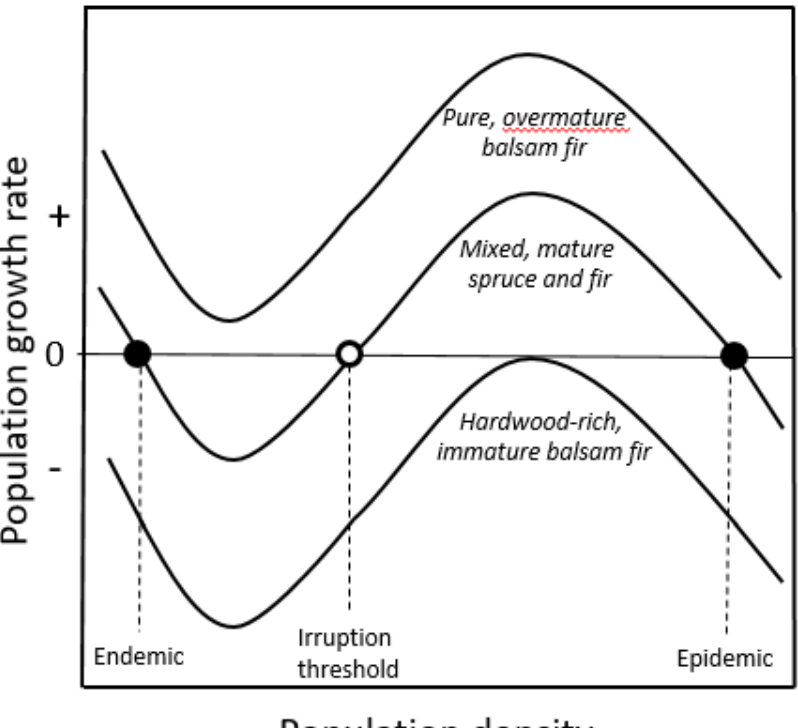
Figure 3. Hypothetical recruitment curves for spruce budworm showing how population density and forest type might interact to influence forest susceptibility and action priorities (adapted from [19]).